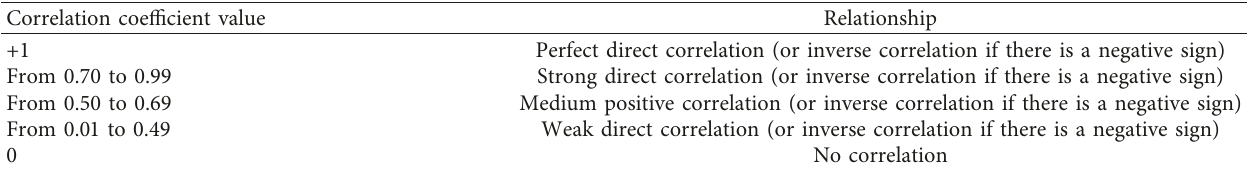
Table 2: Types of